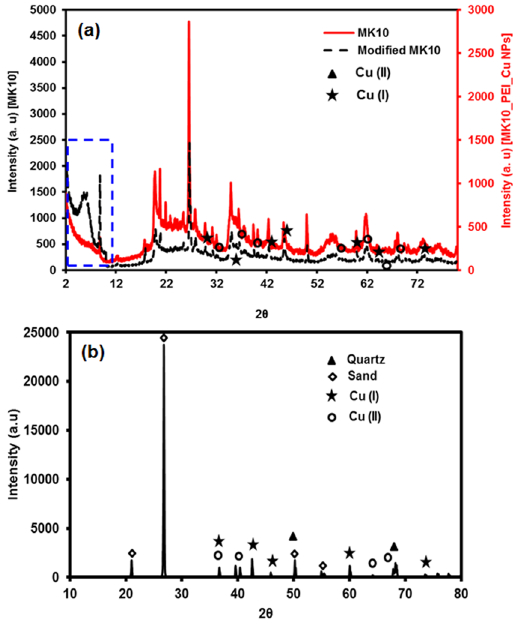
Figure 1. XRD pattern of ( a ) MK10 (before and after the deposition of PEI_Cu NPs); blue dashed box is related to the 001 plane, and ( b )